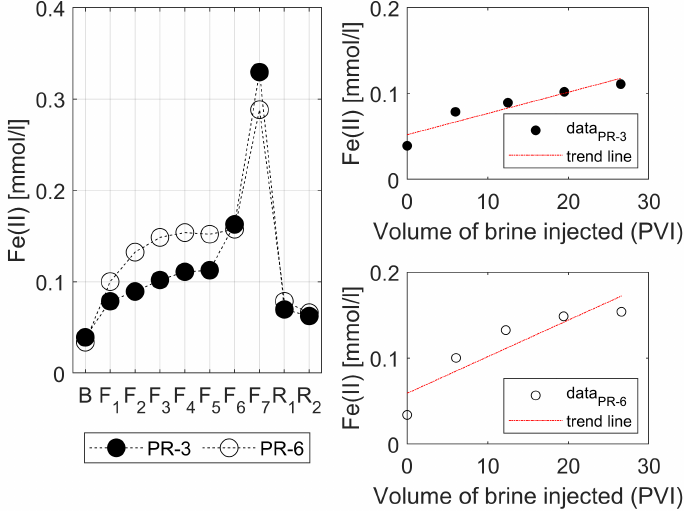
Figure 10. Fe(II) concentration in Parker core plugs flooded with 2D*TB EDTA and trend lines. As observed in Figures 8–10, the dissolution of iron-bearing carbonate cement in all the rocks follows a linear trend, which has an equation of the following form (Equation